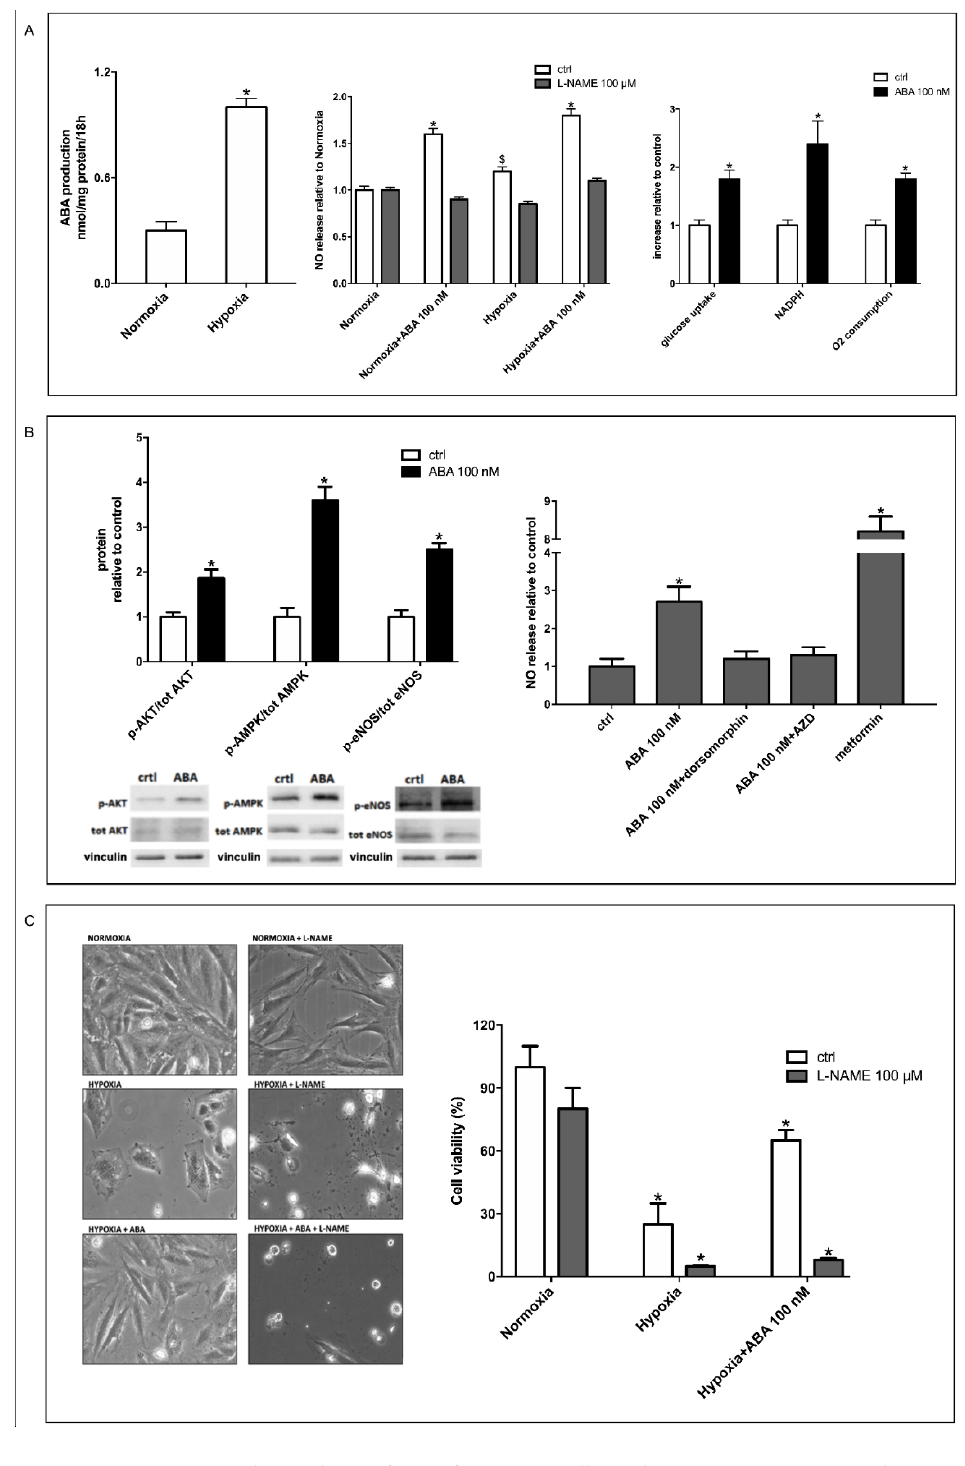
Figure 1. Hypoxia stimulates release of ABA from H9c2 cells, and ABA increases NO production and glucose uptake via AMPK and Akt. H9c2 cardiomyocytes were incubated under hypoxia (30 min under nitrogen flux followed by 3 or 18 h, as indicated in the experiments, in the closed hypoxia incubator chamber at 37 °C), or for the same time under normoxia, without or with 100 nM ABA. The following parameters were explored at the end of the incubation period: ( A ) left panel, ABA content in the culture after 18 h incubation time under normoxia and hypoxia condition; * p < 0.01 relative to normoxia by unpaired t-test; central panel, NO released in the culture medium after 3 h incubation, relative to control (cells under normoxia); * p < 0.01 and $ p < 0.05 relative to control cells under normoxia by unpaired t-test; right panel, glucose uptake, NADPH content and O 2 consumption in cells incubated without (control, ctrl) or with 100 nM ABA for 18 h, under normoxia.